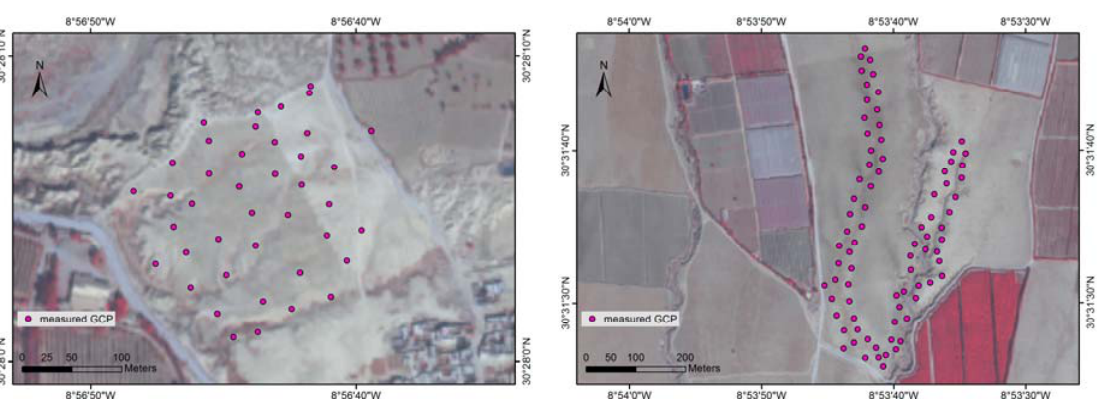
Figure 5. GCP distribution patterns measured with standard GPS (Quickbird2;